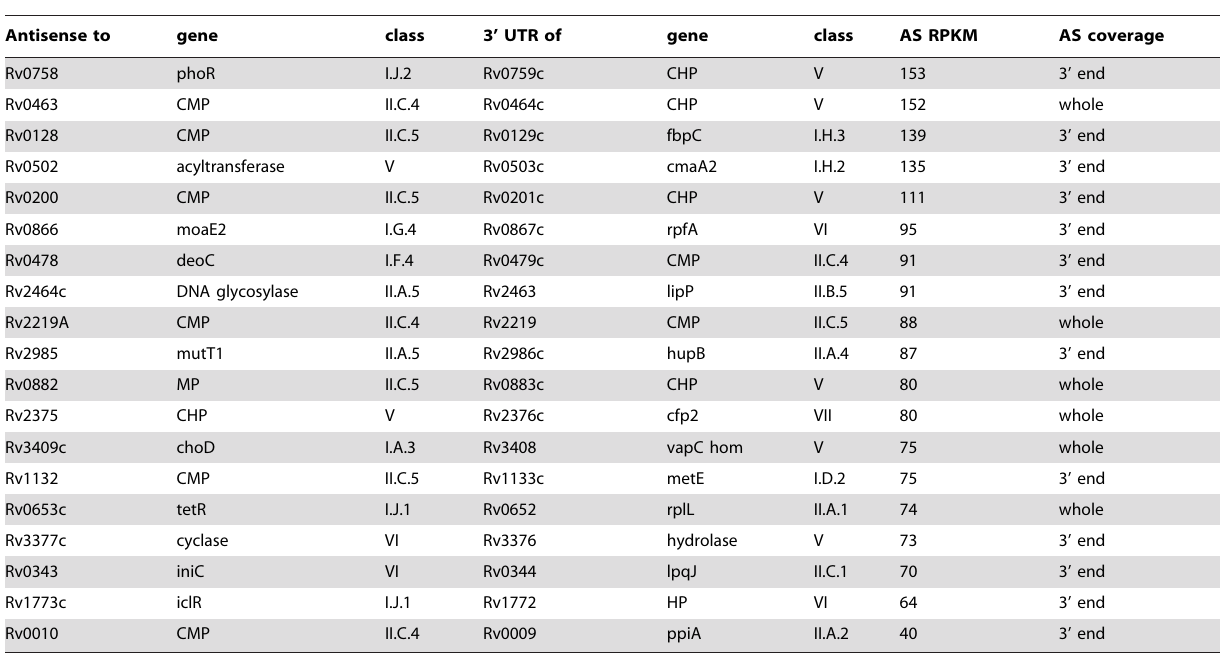
Table 5. Ranking of most abundant antisense transcripts derived from 3’ UTRs.